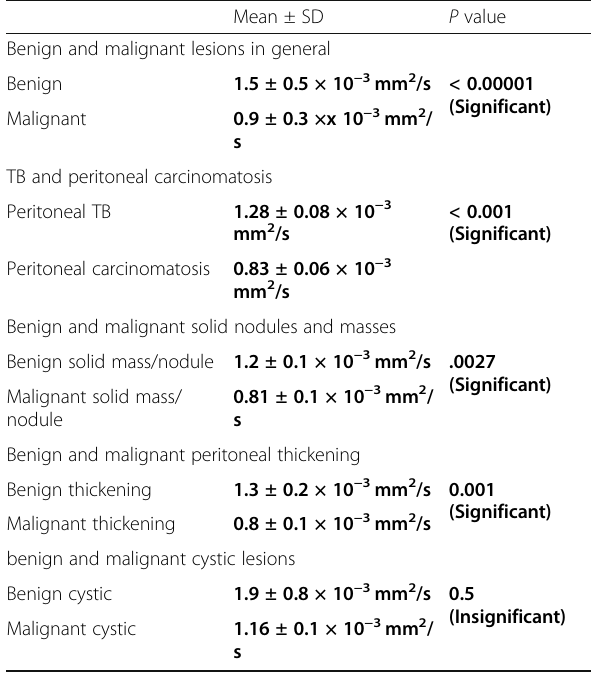
Table 4 Statistical correlation between the ADC values of the different study groups